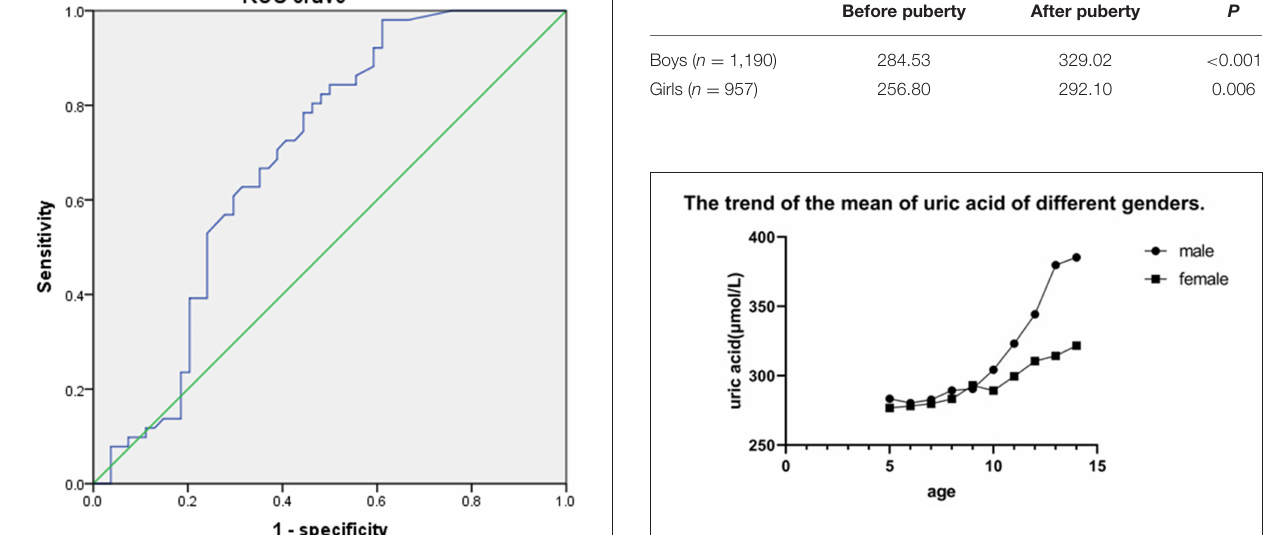
FIGURE 6 | The trend of the mean of uric acid of different